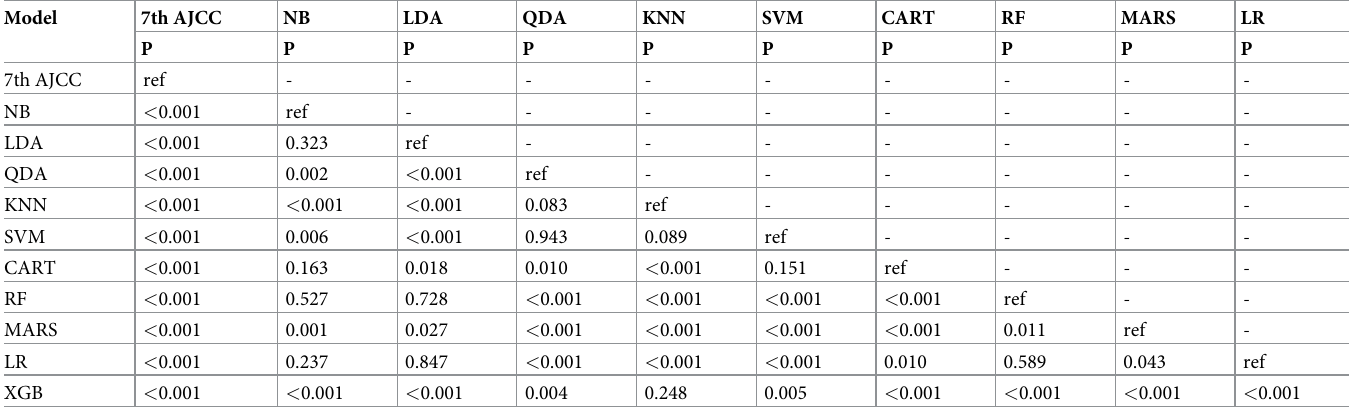
Table 3. The comparison of AUC values for 10 ML algorithms and 7th AJCC stage in the test set.